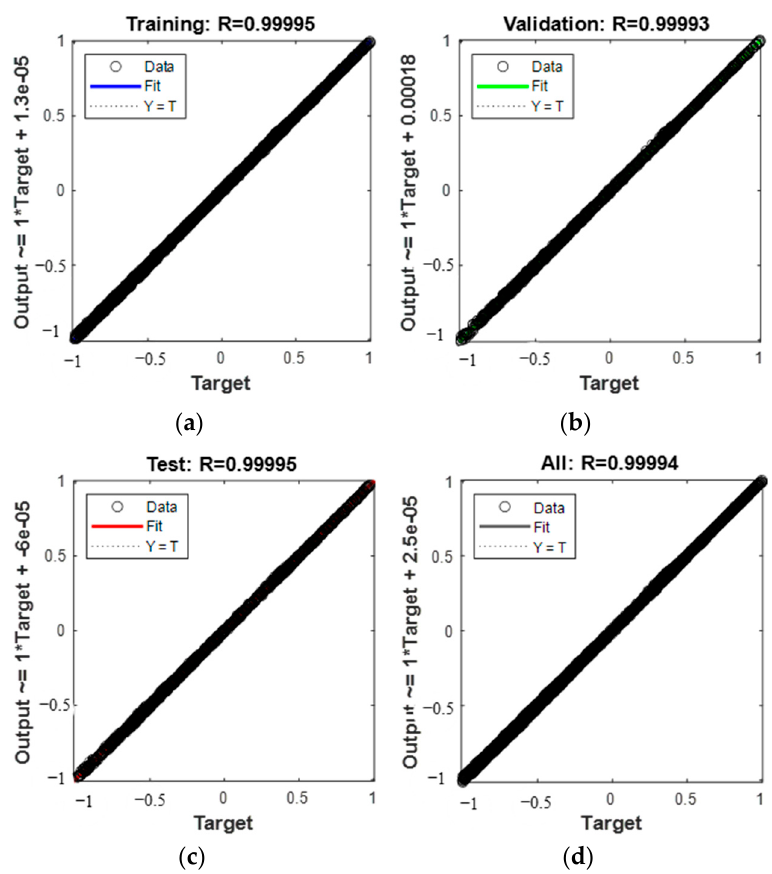
Figure 7. Neural network prediction correlation effect graph; ( a ) training sample correlation; ( b ) validation sample correlation; ( c ) test sample correlation; ( d ) combined correlation.